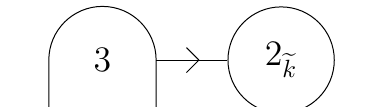
Figure 8 . The quiver representing the dual realization of the SU(3)[1,2] with a CS term on the U(2)